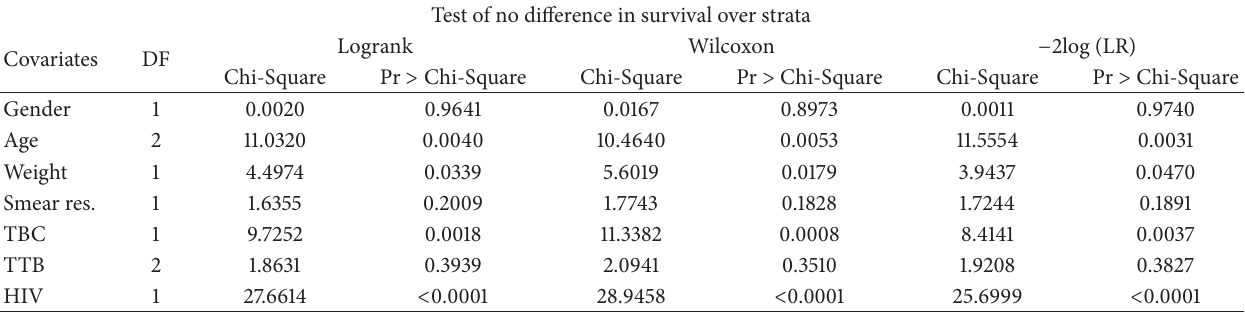
Table 3: Results of the Logrank test, Wilcoxon test and − 2log (LR) for the categorical variables of TB patients under DOTS in six randomly selected AA health